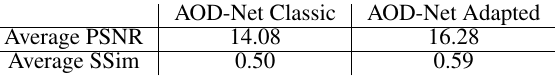
Table 1: The average PSNR and SSim of the test set when tested on Classical and Adapted AOD-Net